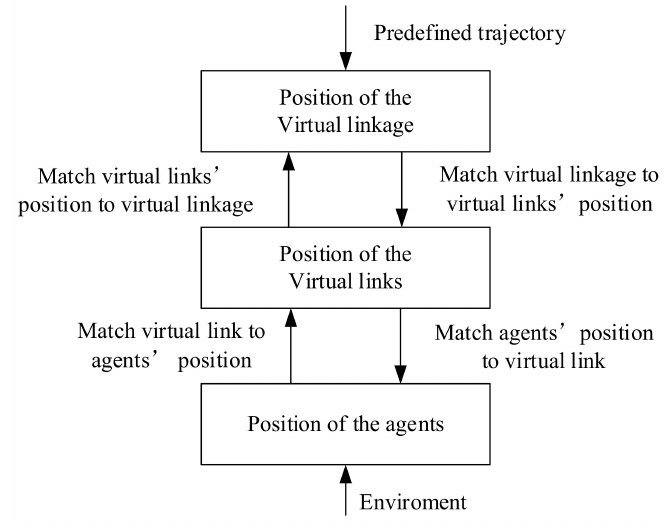
Figure 5. Bi-direction flow control of the virtual linkage.